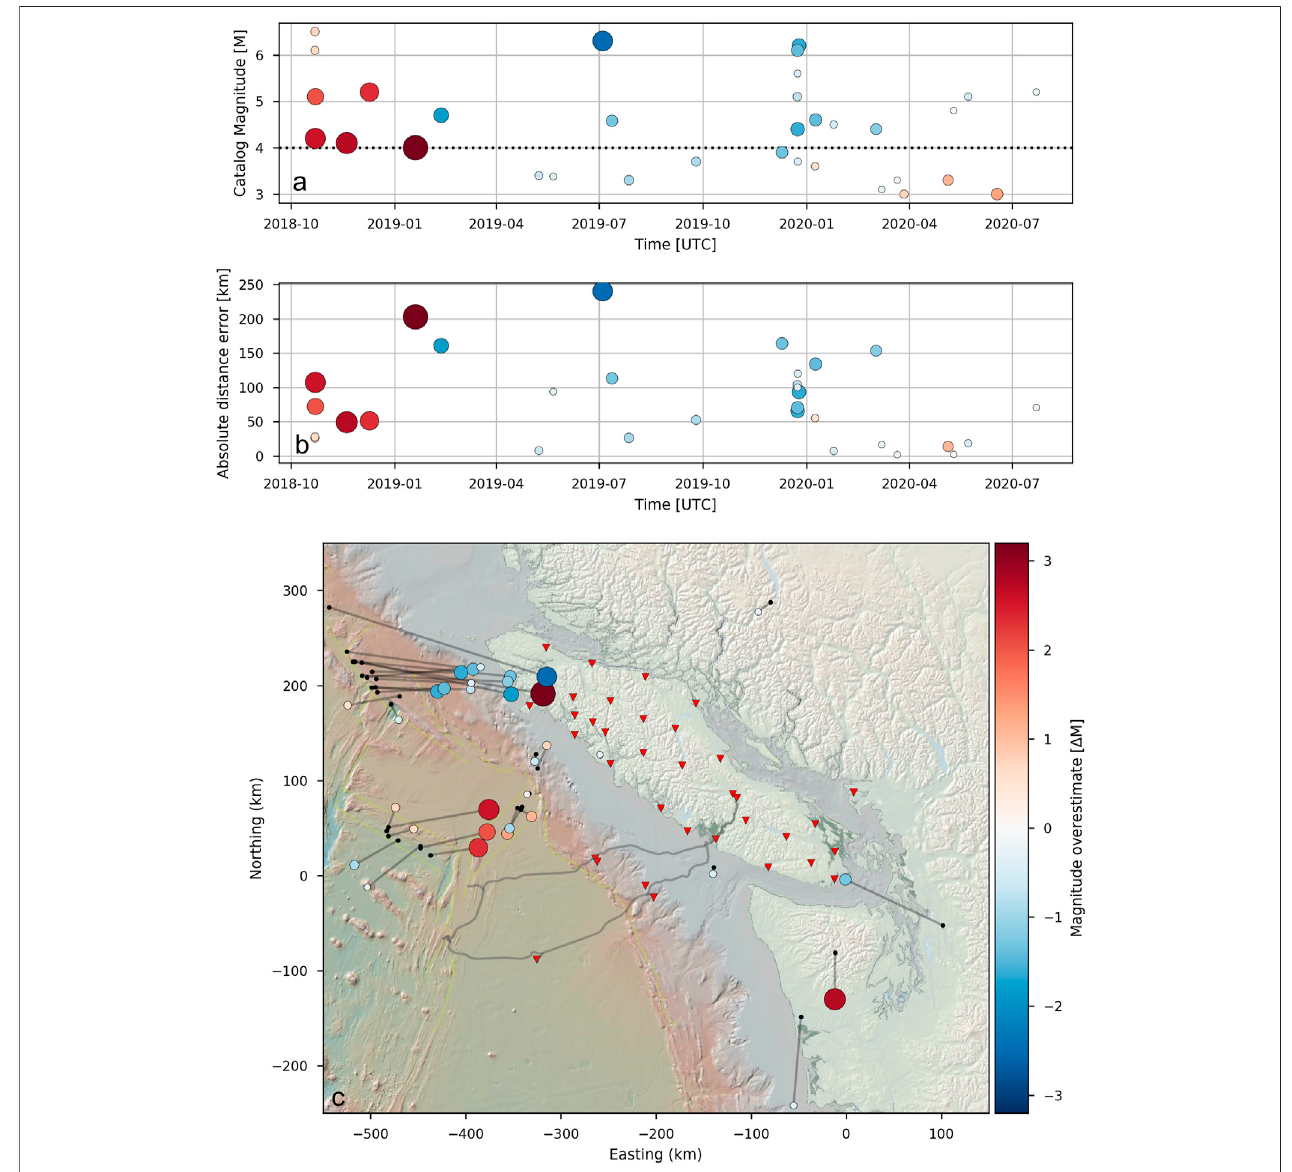
FIGURE 9 | (A) Time series of magnitude errors of the fi nal EEW system event noti fi cation in relation to the same events detected and cataloged by NRCan or USGS (priority was given to NRCan cataloged events). The magnitude error is represented by the colour and the size of the circles. The black dotted line highlights our goal of generating reliablenoti fi cations for relevant eventsof ≥ M4. (B) Time-series ofepicentraldistanceerrorsfor the same eventsand represented bythe samesymbols asin (A) . (C) Mapviewoftheeventsshownin (A) and (B) .WeonlyshoweventsrecordedbytheEEWsystembetweenOctober-2018andOctober-2020withmagnitudes ≥ M3. The EEW system generated epicentres (colored circles) and the reference epicenter locations retrieved from NRCan or USGS (black dots) are connected by lines.